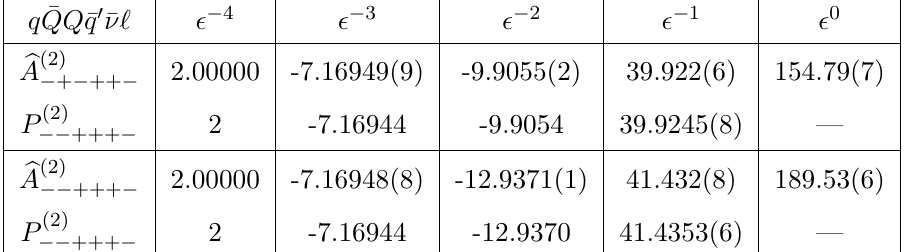
| (cid:0) (cid:1) 1 q ; 2 (cid:22) ; 3 Q ; 4 (cid:22) q 0 ; 5 (cid:22) (cid:23) ; 6 ‘ with the universal pole structure Q